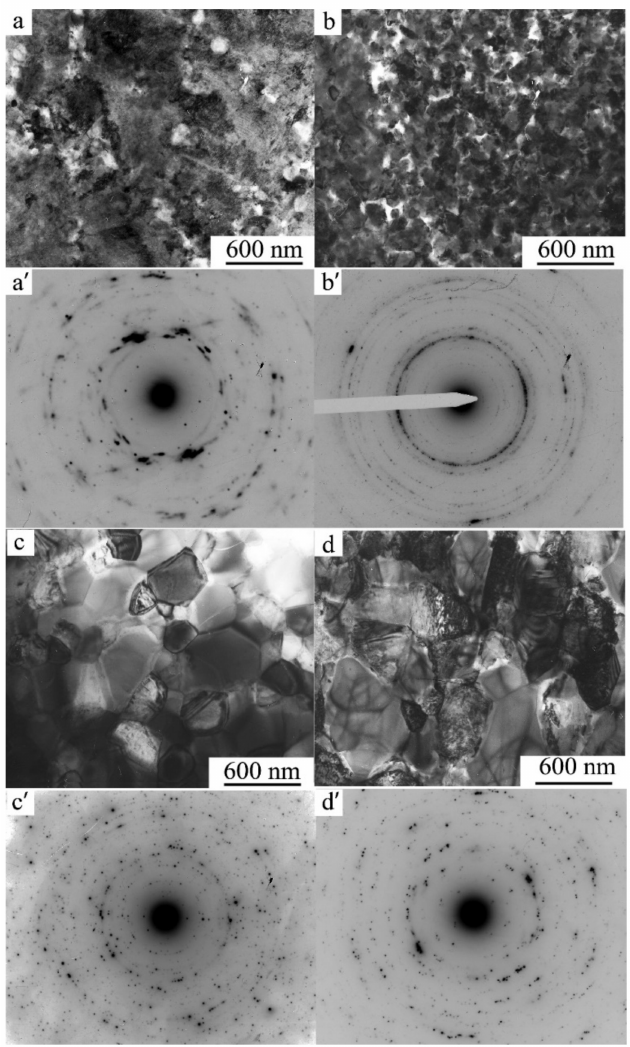
Figure 15. ( a – d ) Bright-field TEM images of microstructure and ( a ’– d ’) corresponding SAED patterns of the Cu-14Al-3Ni alloy after the HPT of 10 revs and isochronous anneals (for 30 min) at temperatures of: ( a , a ’) 573 K, ( b , b ’) 673 K, ( c , c ’) 773 K, and ( d , d ’) 873